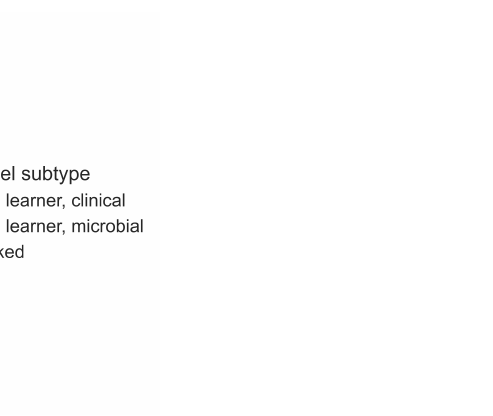
Figure A2. Overfitting analysis for colorectal cancer dataset comparing stacked model’s and base learners’ performance separated by view during cross-validation. Point values refer to median AP values and bars refer to estimated confidence intervals. Values for base learners trained on microbial view are aggregated together without distinction with regard to an individual base learner.